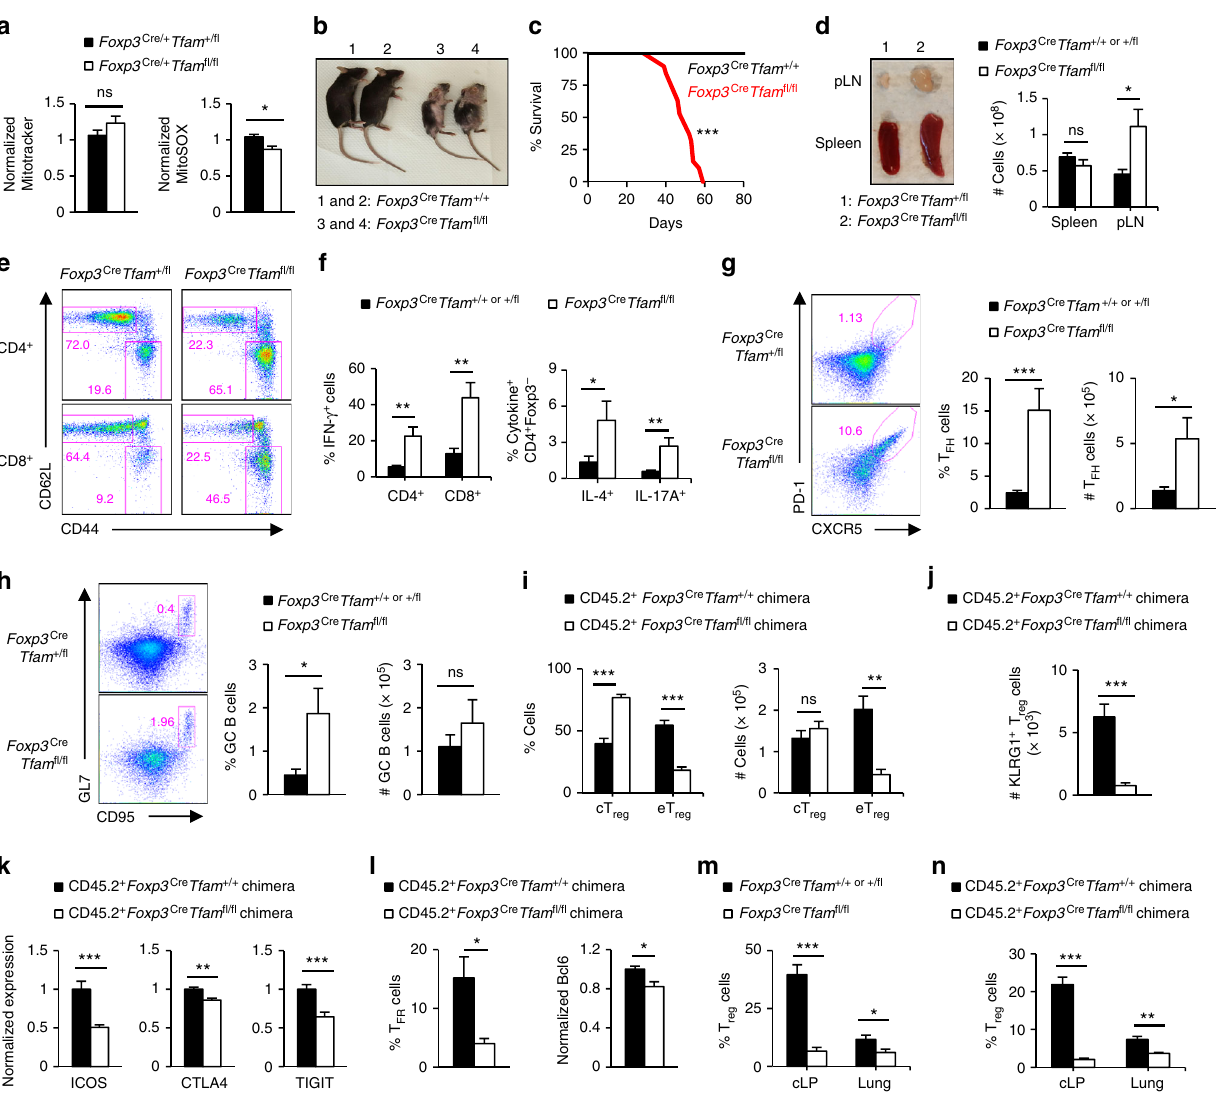
Fig. 8 Mitochondrial metabolism is critical for T reg -cell function in vivo. a Quanti fi cation of Mitotracker (left) and MitoSOX (right) in T reg cells from Foxp3 Cre/ + Tfam + / fl and Foxp3 Cre/ + Tfam fl / fl mosaic mice. b Image of 8-week-old mice. c Survival curve of Foxp3 Cre Tfam + / + ( n = 14) and Foxp3 Cre Tfam fl / fl mice ( n = 19). d Representative image of lymphadenopathy (left) and cell numbers in the spleen and peripheral lymph nodes (pLN) of Foxp3 Cre Tfam + / fl and Foxp3 Cre Tfam fl / fl mice. e Flow cytometry analysis of naive and effector/memory CD4 + Foxp3-YFP – (depicted as CD4 + ) or CD8 + T cells in Foxp3 Cre Tfam + / fl and Foxp3 Cre Tfam fl / fl mice. f Quanti fi cation of cytokine production by CD4 + Foxp3 – and CD8 + T cells. g Flow cytometry analysis (left) and frequency and number (right) of T FH cells. h Flow cytometry analysis (left) and frequency and number (right) of GC B cells. i , j Quanti fi cation of frequencies and numbers of cT reg cells and eT reg cells ( i ) or number of KLRG1 + T reg cells ( j ) in the spleen of mixed bone marrow chimeras. k Quanti fi cation of ICOS, CTLA4, and TIGIT expression in T reg cells from mixed bone marrow chimeras. l Quanti fi cation of the frequency of T FR cells (left) and Bcl6 expression in total Foxp3 + T reg cells (right) in mixed bone marrow chimeras. m , n Quanti fi cation of frequency of T reg cells in the colon lamina propria and lung of Foxp3 Cre Tfam + / + or + / fl or Foxp3 Cre Tfam fl / fl mice ( m ) or mixed bone marrow chimeras ( n ). Error bars show mean ± s.e.m. * P < 0.05; ** P < 0.01; per group, or are quanti fi ed from fi ve ( a ), eight or nine ( d , f ; Foxp3 Cre Tfam fl / fl or Foxp3 Cre Tfam + / + or + / fl mice, respectively), twelve ( g ), ten ( h ), nine